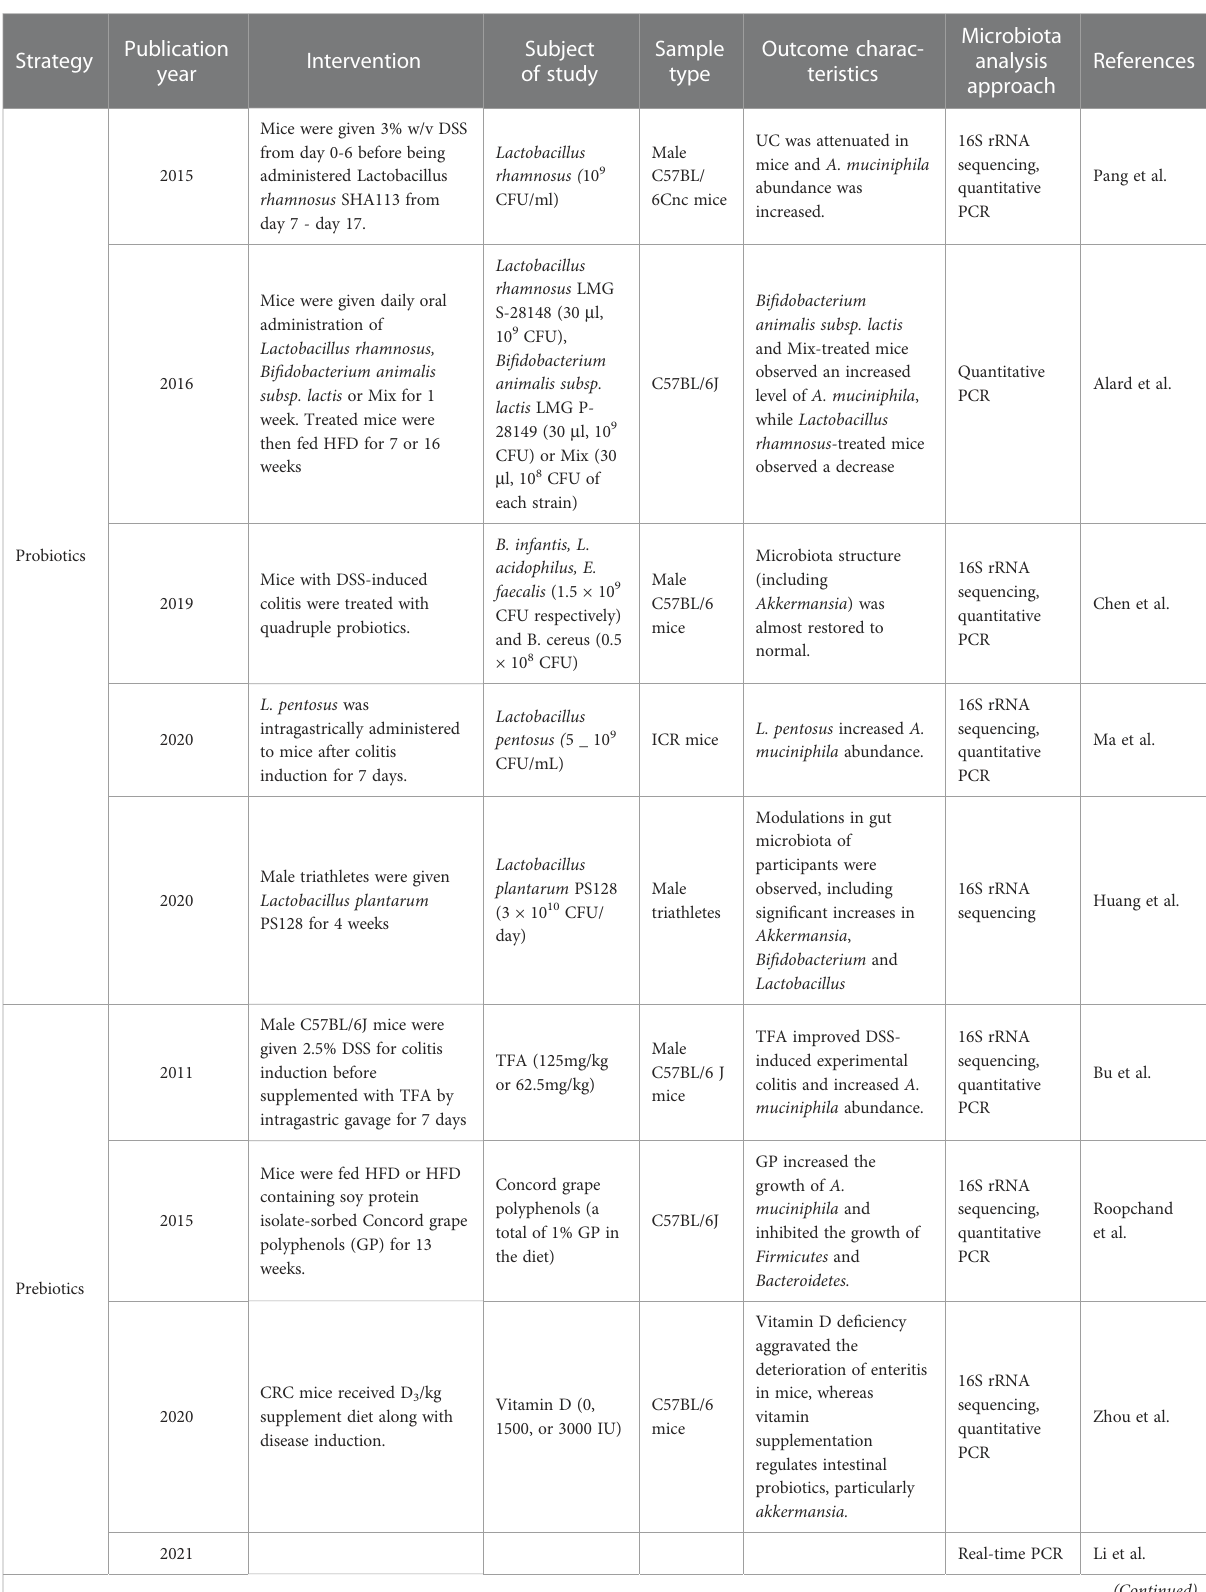
TABLE 4 Strategies to promote abundance of A. muciniphila in colitis animal